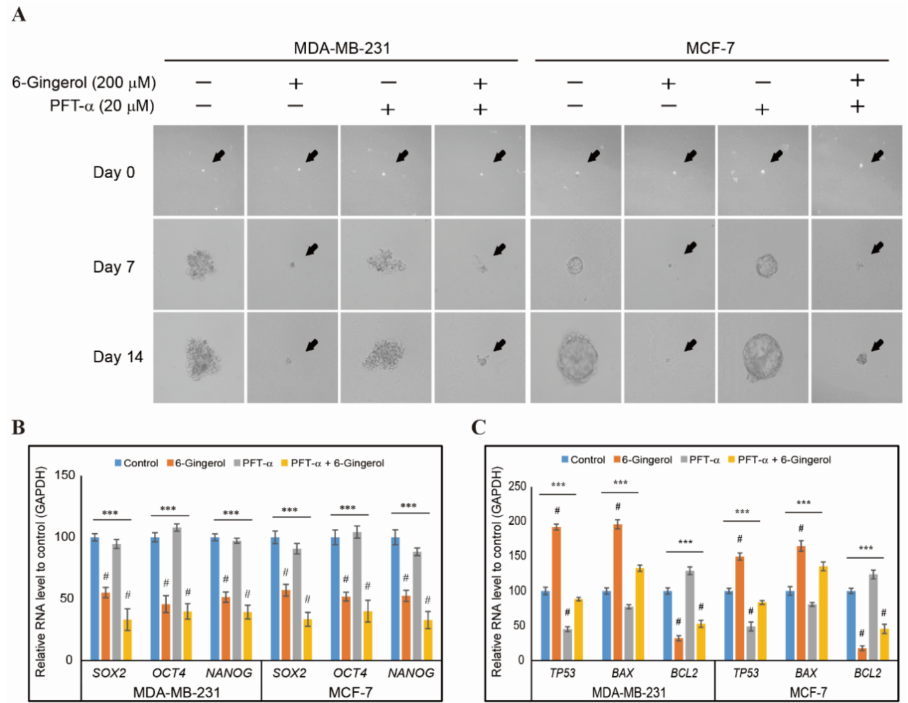
Figure 8. 6-gingerol inhibits tumorsphere formation. ( A ) Suppression in sphere forming ability of MDA-MB-231 and MCF-7 cells by 6-gingerol treatment. Representative photographs are presented (scale bar, 15 µ m). Cells were incubated with sphere forming media for 14 days with or without 200 µ M 6-gingerol and 20 µ M PFT- α . ( B ) qPCR analysis of expression of cancer stem cell marker genes. The representative expression of the SOX2, OCT4, and NANOG mRNA is shown; Cp values were then normalized to GAPDH mRNA. Controls are set to 100. *** p < 0.001 (ANOVA test). # p < 0.001 vs. control. ( C ) qPCR analysis of expression of p53 and intrinsic apoptosis genes. The representative expression of the TP53, BAX, and BCL-2 mRNA is shown; Cp values were then normalized to GAPDH mRNA. Controls are set to 100. *** p < 0.001 (ANOVA test). # p < 0.001 vs.